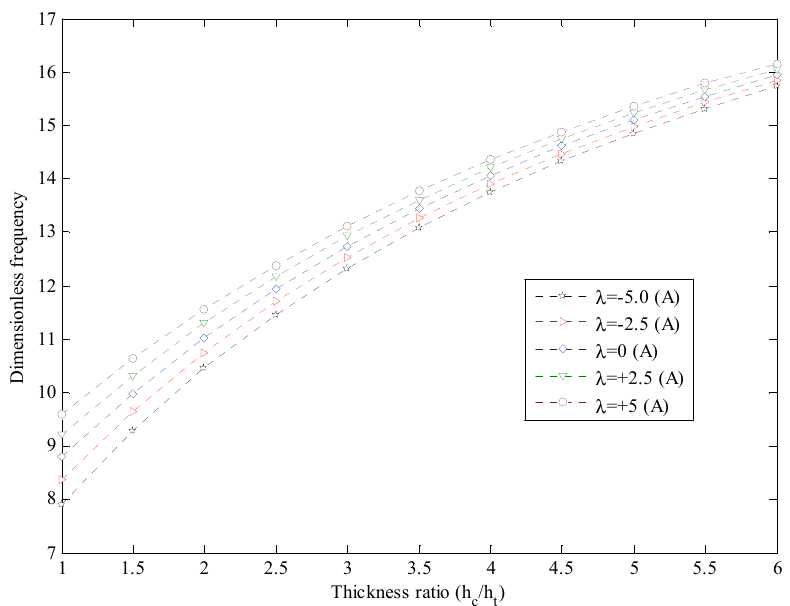
Figure 5. Dimensionless frequency versus thickness ratio for different variations in external mag- netic potential.